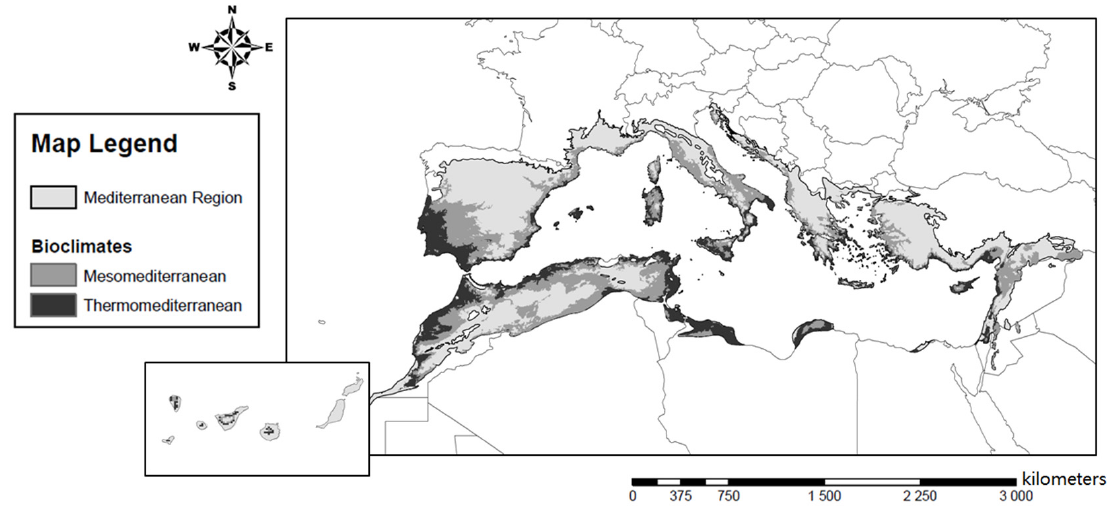
Figure 3. Map of thermotypes in the Mediterranean Basin. The optimum thermotype for olive cultivation is the thermo- and meso-Mediterranean. Geographic Coordinates Mediterranean Basin: 38 ◦ N 17 ◦